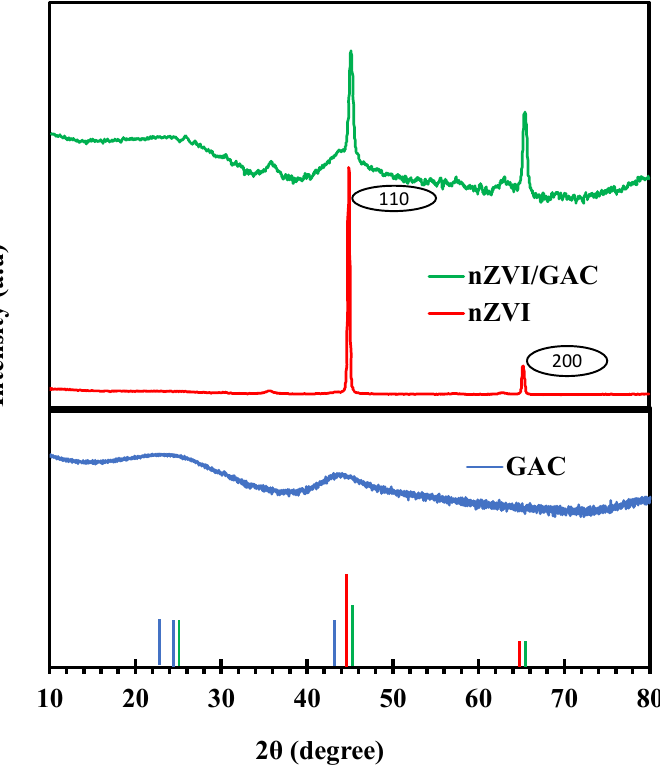
Figure 3. XRD analysis of GAC-synthesized-nonsupported nZVI and GAC-supported nZVI. 3.2. Adsorption of Organic Selenium by nZVI and nZVI/GAC Composites The removal capacity of organoselenium by nZVI and nZVI/GAC is presented in Figure 4. In comparison, higher capture capacity was observed with GAC-supported nZVI particles, as opposed to the minimal uptake capacity by nZVI. Approximately 59.2% and 10.8% removal were achieved for SeCys and SeMet by nZVI after 6 h, whereas about 97.2% and 64.9% of SeCys and SeMet were removed by nZVI/GAC composite. Significantly, a higher removal capacity of organoselenium was observed with the synthesized